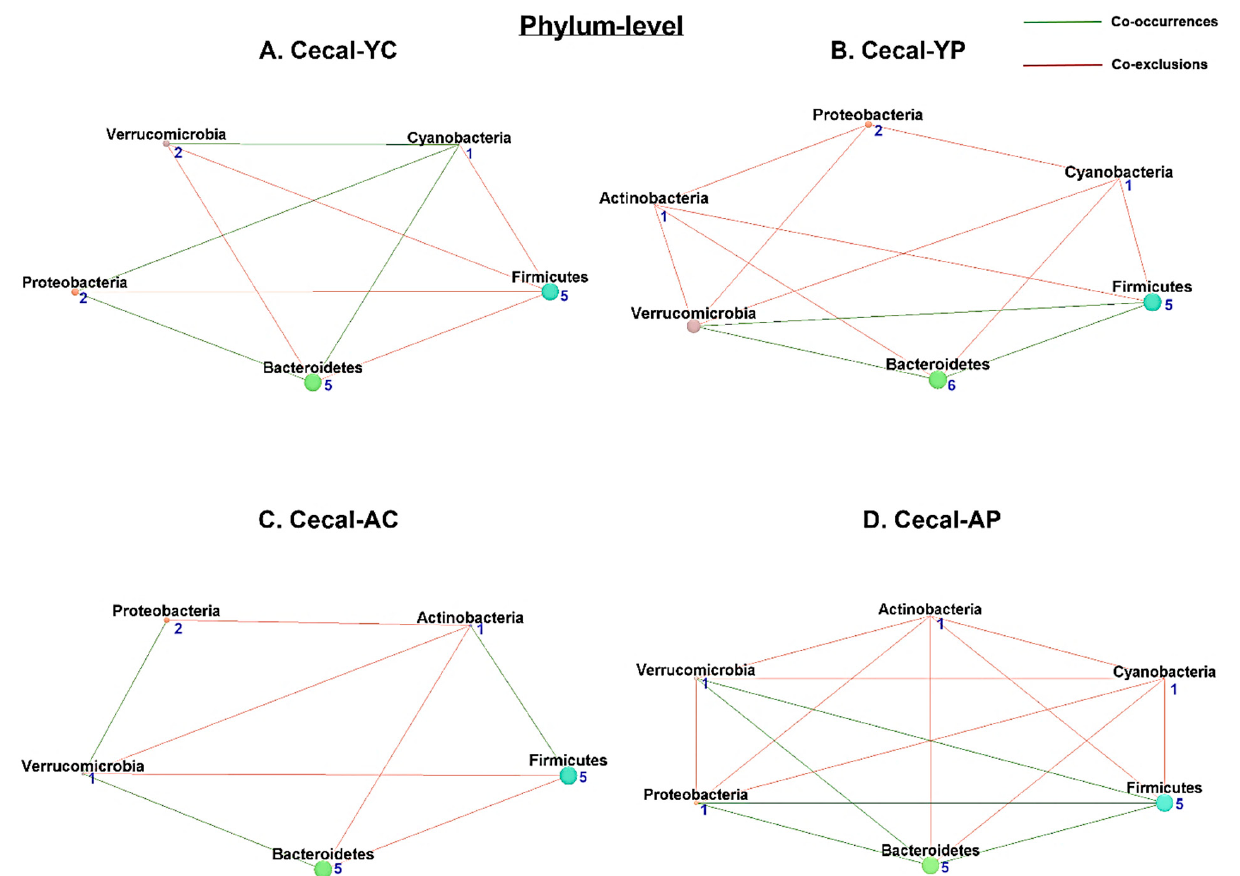
Figure 9. Microbial co-occurrence in the cecal microbiome in young and aging mice at the phylum level. Co-occurrence networks were constructed based on relative abundance profiles of fecal microbes using Kendall’s Tau correlation analysis in young control ( A ), young probiotic ( B ), aging control ( C ), and aging probiotic ( D ) groups. Each node represents a phylum. Each edge indicates the sign of the association (green = positive (co-occurrences), red = negative (co-exclusions)). The thickness of the nodes represents the level of association between taxa.